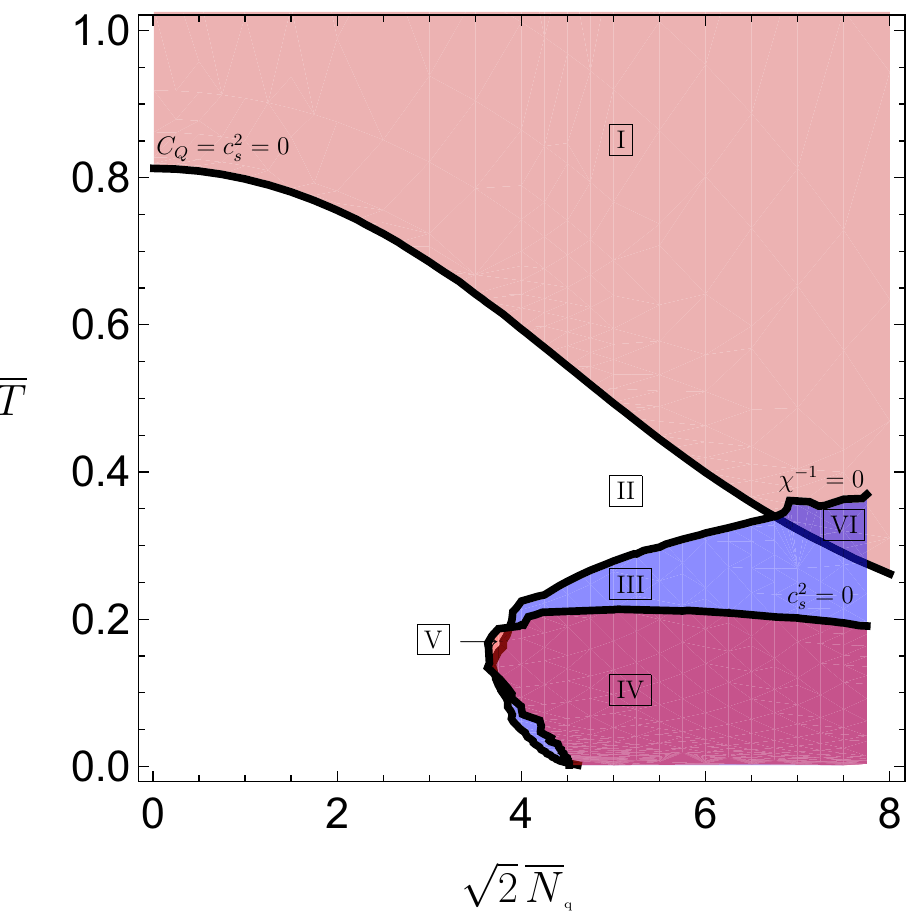
Figure 2 . Phase diagram of the system as a function of temperature and charge density. The and T are defined in (2.60) and (3.8), respectively. The different dimensionless quantities N q curves correspond to the locus where the indicated quantity crosses zero and thus changes sign (see table 1) and divide the diagram into six regions. Note that Region III includes a small area below and to the left of region